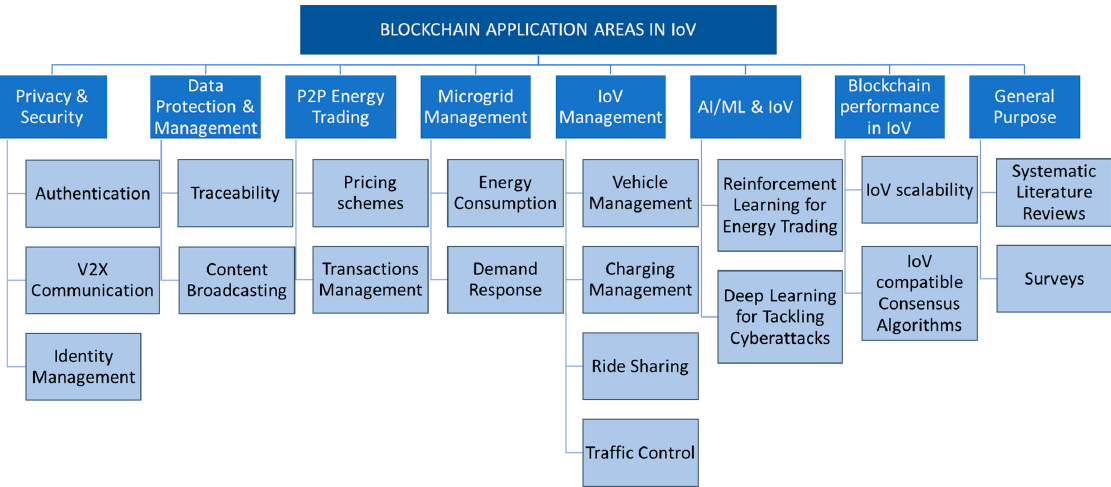
Figure 6. Blockchain application areas in the IoV.